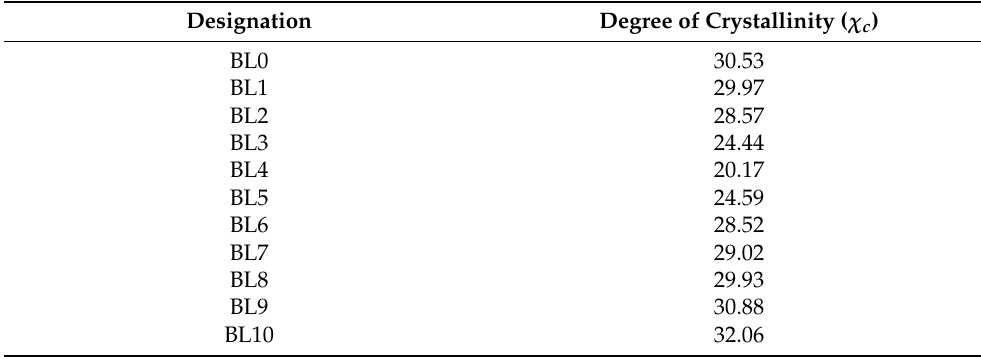
Table 3. Designation for the polymer blend systems and their respective degree of